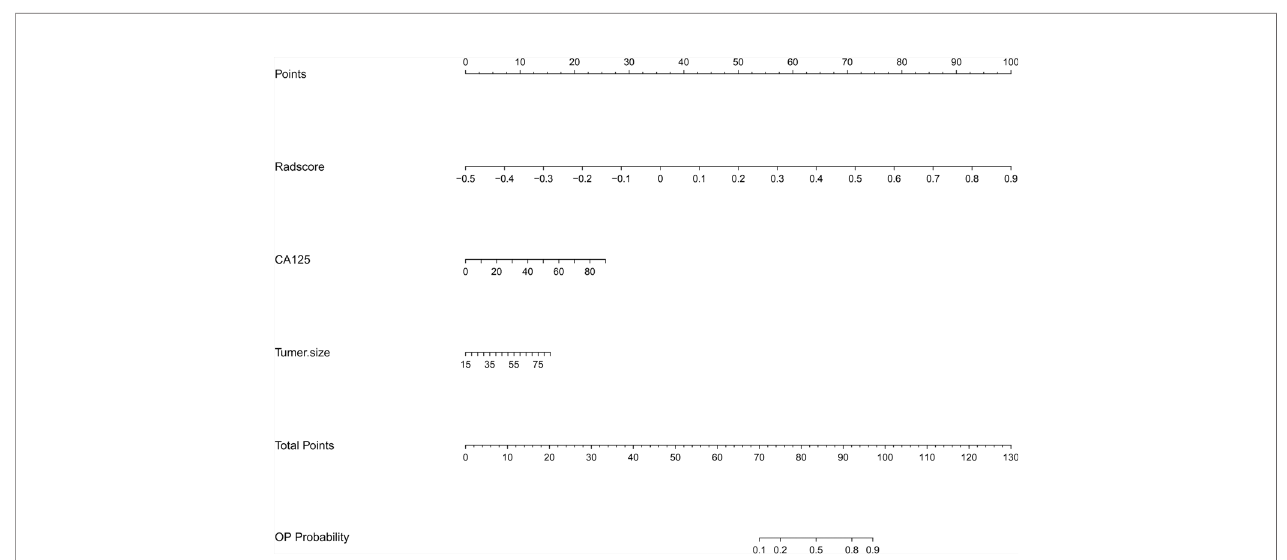
FIGURE 4 | The radiomics nomogram incorporating the selected radiomics features with clinical parameters (CA125 and tumor size) in the primary group. To use the nomogram, locating the margin according to the patient information, drawing a line straight up to the point axis to obtain the score associated with the margin, and repeating for the radscore. By summing the scores of each point and locating it on the total points and drawing a line straight down to the bottom axis, the estimated probability of DMI in G 1/2-EEC patients for ovarian preservation can be determined.